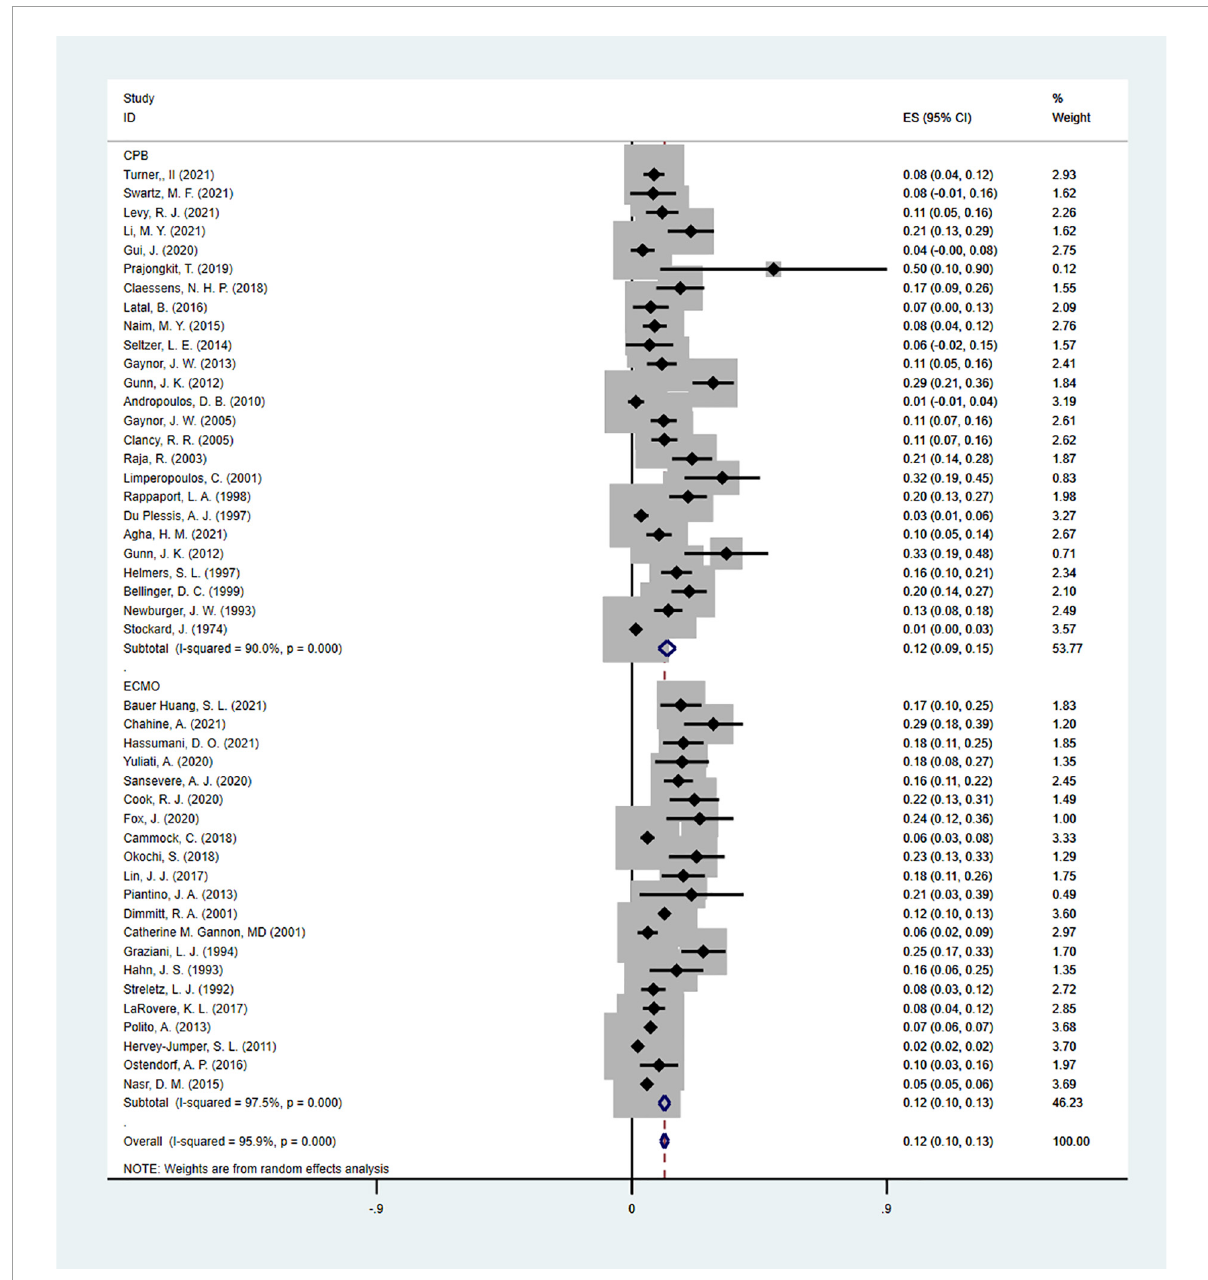
FIGURE5 The forest plot of the incidence of electroencephalographic (EEG) seizures after mechanical support in pediatrics.